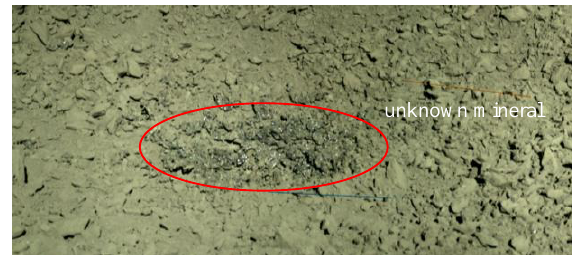
Figure 5. Pancam image mosaic generated from images taken at waypoint LE00803.